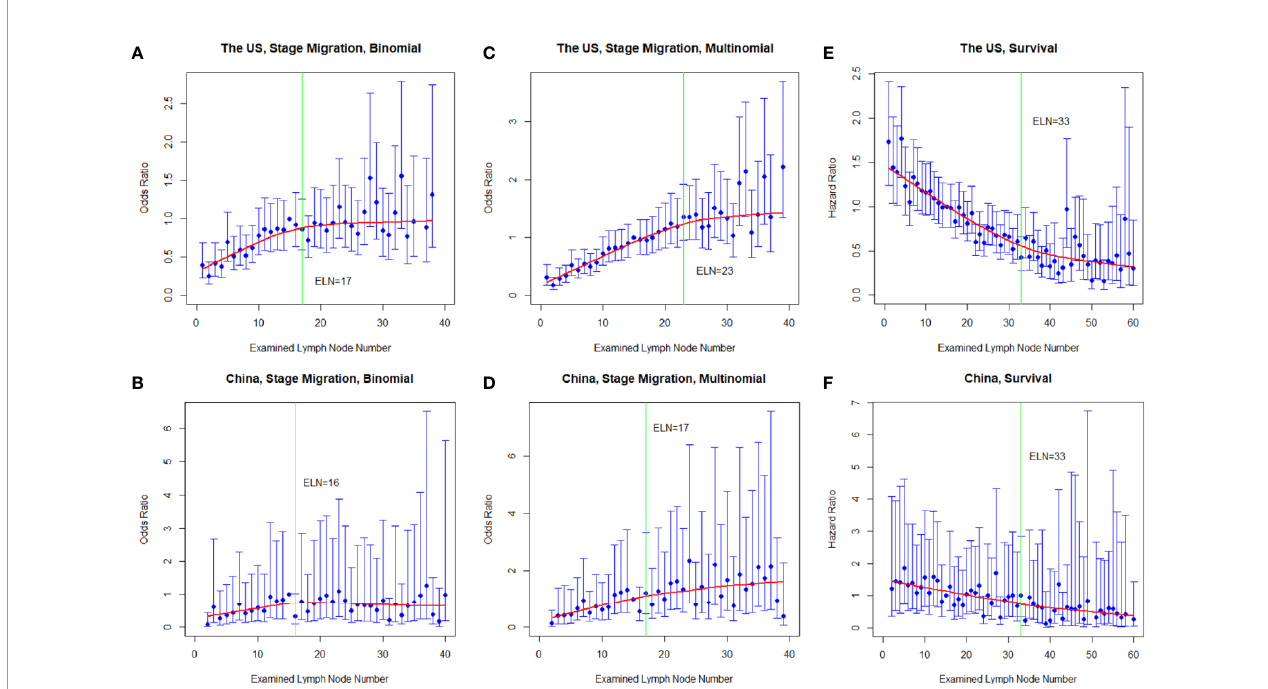
FIGURE 1 | Multivariable-adjusted odds ratios (ORs) for negative-to-positive (binomial; A , B ) and lower-to-higher nodal stage migration (multinomial, (C , D) and hazard ratios (HRs) for overall survival (E, F) with each additional examined lymph node (ELN) in resected gastric adenocarcinoma in the US and China cohorts. ORs were calculated using multivariable binomial/multinomial logistic regression adjusting for year of diagnosis, sex, age, tumor local invasion, differentiation, location, size, and resection type. HRs were computed using multivariable Cox proportional hazards regression adjusting for year of diagnosis, sex, age, tumor local invasion, differentiation, location, size, metastatic lymph node number, and resection type. The adjusted ORs and HRs and the corresponding 95% con fi dence intervals are shown in blue, and the smoothed curves fi tted using the LOcally WEighted Scatterplot Smoothing (LOWESS) method with a default bandwidth of 2/3 are shown in red. The vertical green lines indicate the determined structural breakpoints using the Chow